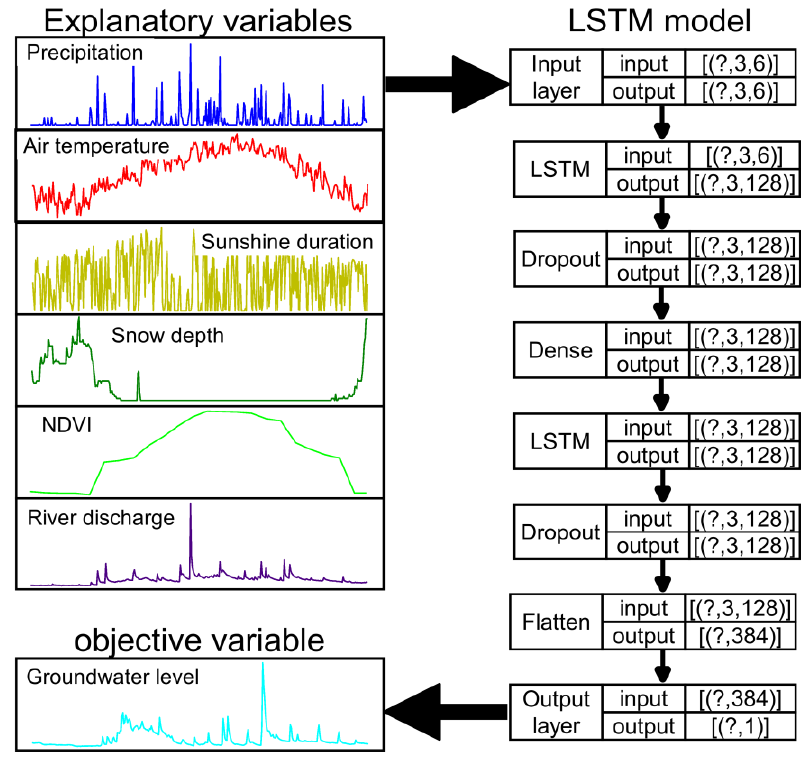
Figure 6. The LSTM structure with six explanatory variables for groundwater level prediction. “?” in the right-hand subfigure represents the number of the learning data.